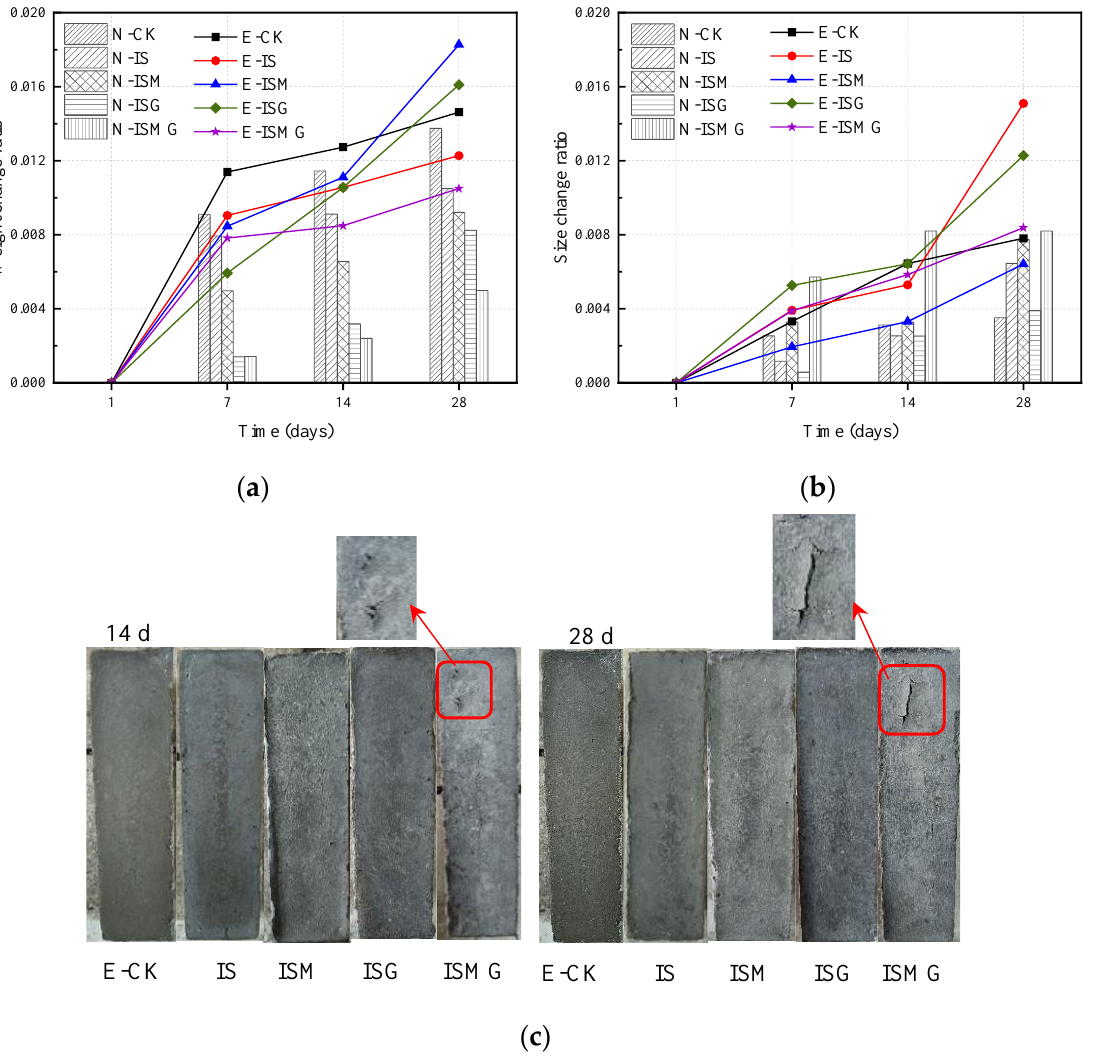
Figure 2. Change of specimens in weight, size and appearance under different corrosion conditions during different periods: ( a ) weight change, ( b ) size change, ( c ) appearance of mortars exposed to external sulfate solution.